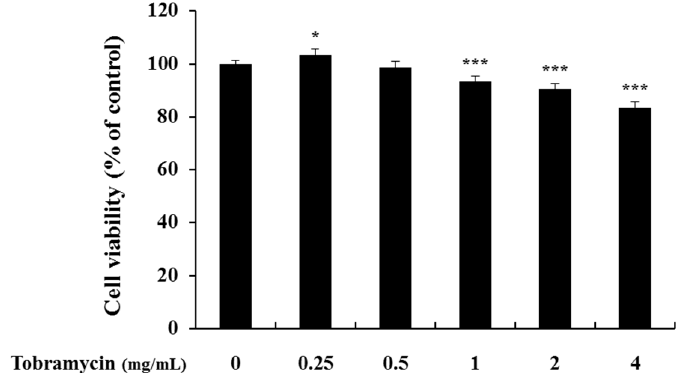
Figure 14. Cell viability of tobramycin-treated HaCaT keratinocyte cells. The cells were treated with various concentrations of tobramycin for 24 h. Data are presented as mean ± standard deviation (SD) of at least four independent experiments ( n = 4). * indicates p < 0.05, *** p < 0.001 vs. control.